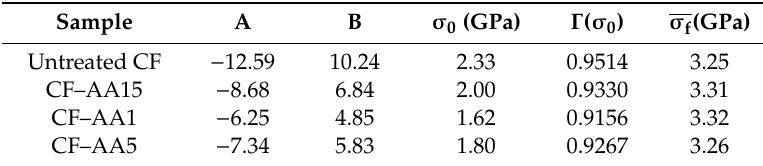
Figure 7. Weibull distribution curves of tensile strength for CF monofilaments under different plasma treatments: ( a ) untreated CF, ( b ) CF–AA15, ( c ) CF–AA1, and ( d ) CF–AA5. Table 2. Tensile strength of CFs after different plasma treatments.